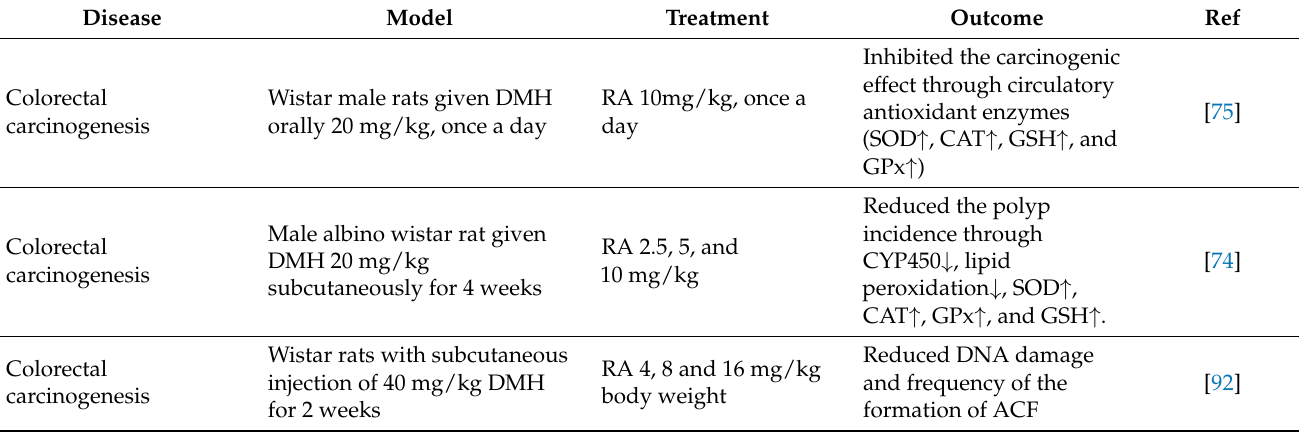
Figure 2. Mechanisms of tumorigenesis prevention effects of RA. When cells undergo oxidative stress or inflammatory factors (ILs), ROS and MDA are accumulated. The intracellular peroxidases SOD dismutate superoxide anion to H 2 O 2 , then GPx and CAT catalyze the decomposition of H 2 O 2 into H 2 O to maintain cellular ROS homeostasis. When cells are continuously stimulated by ROS, accompanied by the activation of NF- κ B and COX-2, the normal cells can abnormally proliferate, differentiate, and escape apoptosis, leading to tumorigenesis. RA inhibits the secretion of IL-1 β and IL-6, the expression of NF- κ B and COX-2, and downregulates the content of ROS and MDA. Table 2. Summary of tumorigenesis prevention effects of RA.